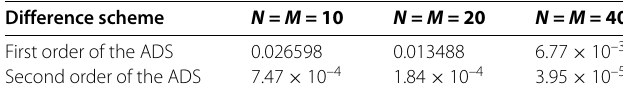
Table 5 Error of u in example (57)